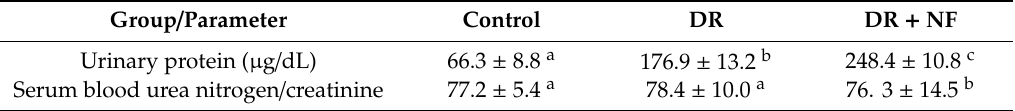
Table 1. Nifedipine (NF) aggravated the renal function of rats with doxorubicin (DR)-induced chronic kidney disease 1